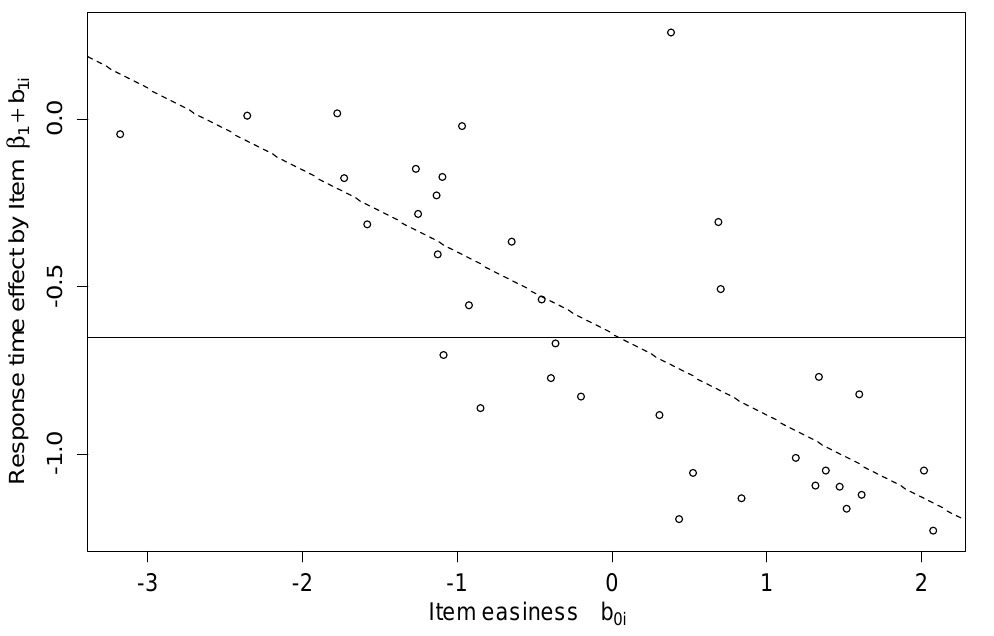
Figure 2. Item response time effect by item. The solid line indicates the fixed response time effect, the dots show how the response time effect is adjusted by item. For difficult items the item response time effect gets less negative, whereas it gets more negative for easy